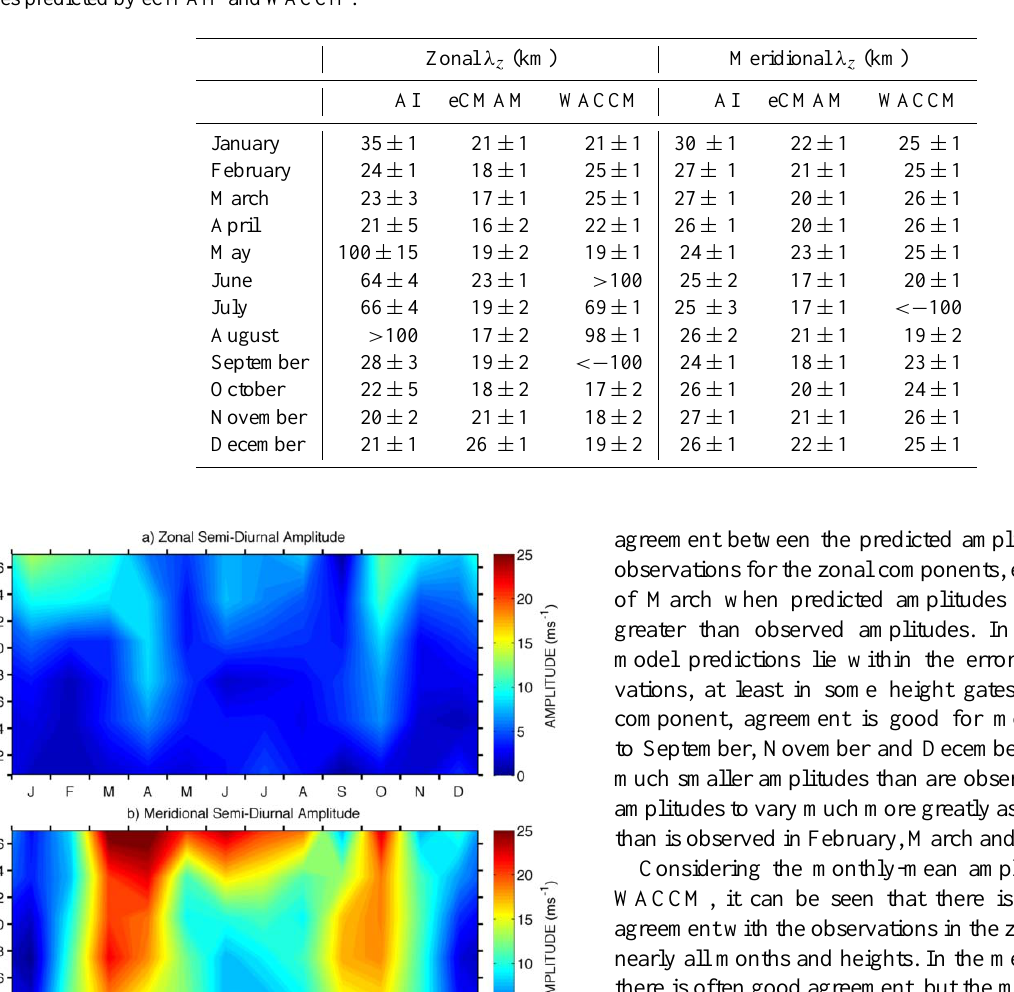
Table 1. Table of the mean diurnal tide vertical wavelengths (km) as observed by the Ascension Island radar (AI) for each month, and the values predicted by eCMAM and WACCM.